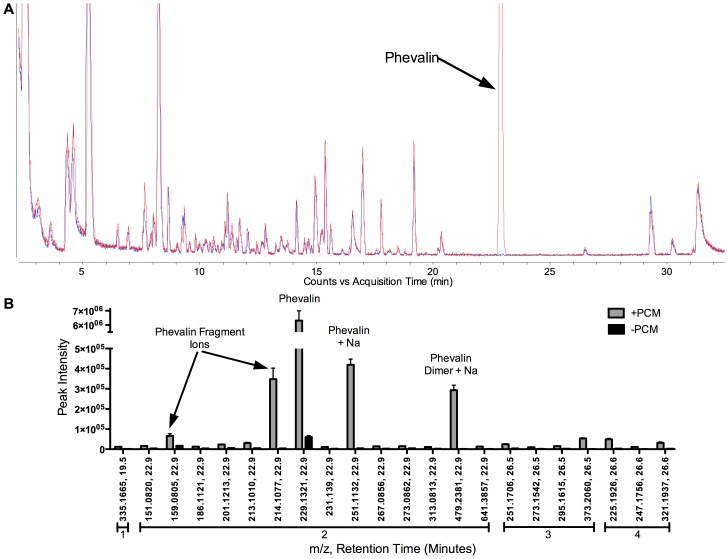
Increased amounts of phevalin did not impact the extracellular metabolome of S. aureus as detected by HPLC-MS.(A) Overlays of representative HPLC-MS base-peak chromatograms of +PCM (red) and –PCM (blue) revealed no substantial differences with the exception of phevalin (arrow). (B) XCMS analysis identified 22 features significantly (p<0.05) regulated ±2 fold in +PCM relative to –PCM. Those features grouped by RT into four groups (numbered bars). Group 2 contained phevalin, its fragment ions, and various adducts. Groups 1, 3, and 4 contained trace features associated with compounds used during the synthesis of phevalin. Data represent means ± SEM, n = 3.